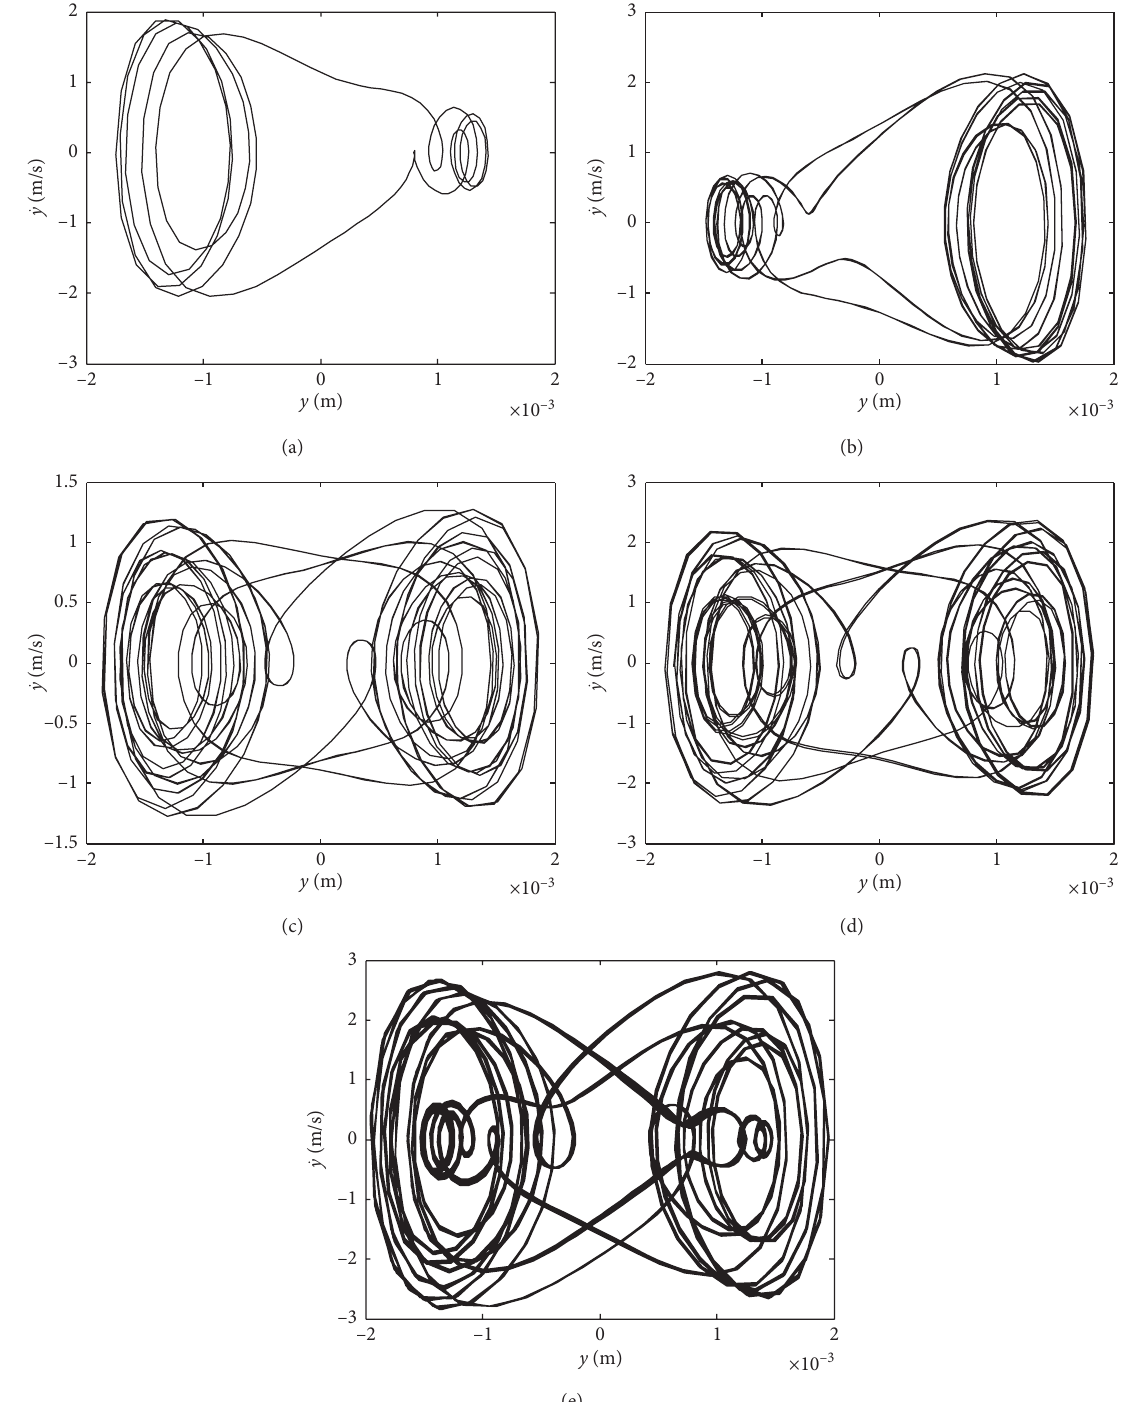
Figure 11: Phase path of the vertical vibration under varying external excitation amplitude: (a) F N, (d) F 0 � 6.05 e 5 N, and (e) F 0 � 6.55 e 5